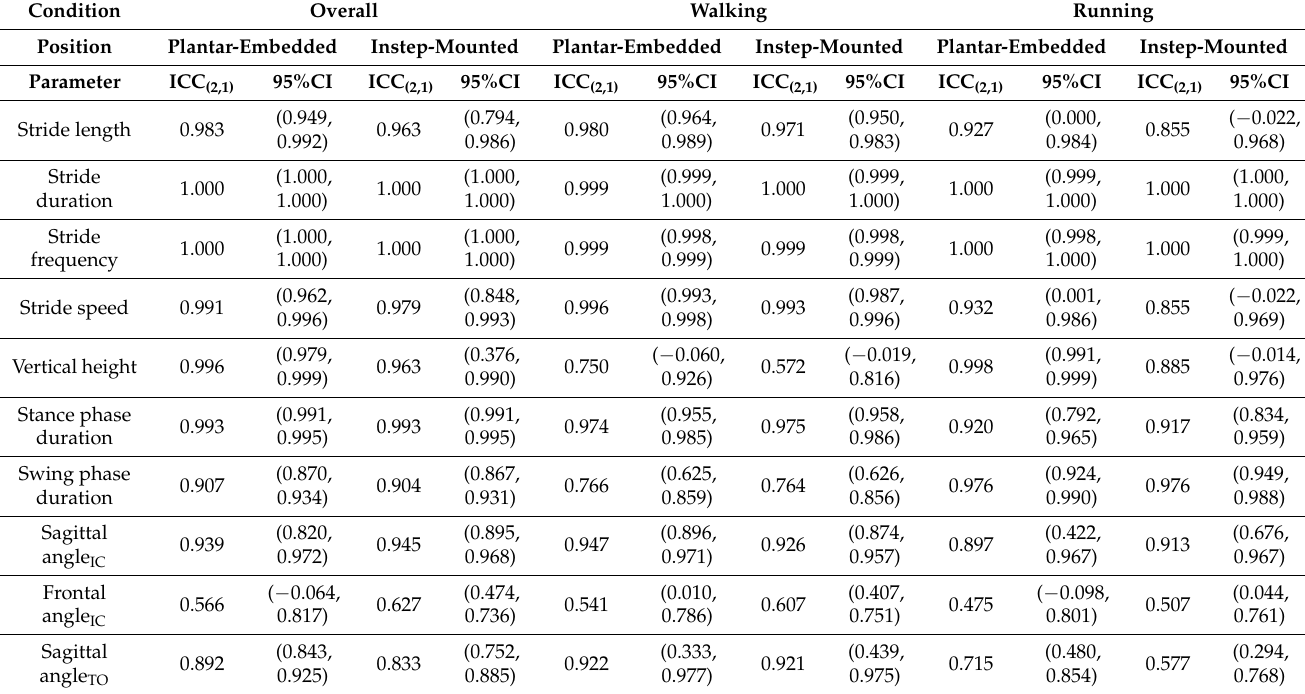
Table 2. Intraclass correlation coefficients of the gait parameters from ORPHE ANALYTICS and optical motion